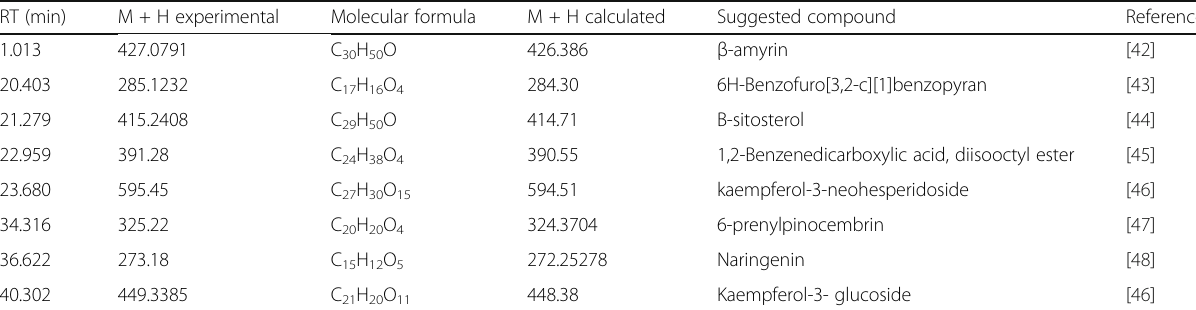
Table 2 LCMS data of the compounds identified in the extract RT (min) M + H experimental Molecular formula M + H calculated Suggested compound